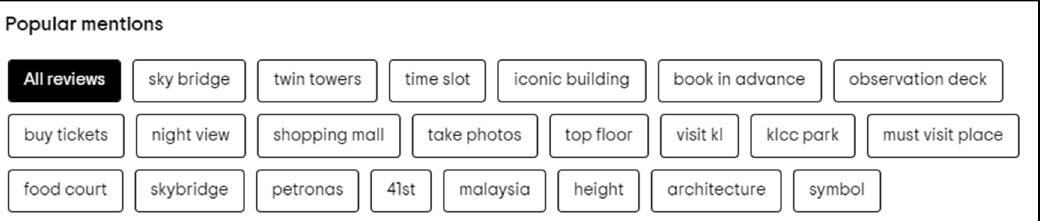
Figure 8. TripAdvisor reviews’ tags for Petronas Towers. Table 8. Extracted top semantic terms of the baseline and proposed methods.